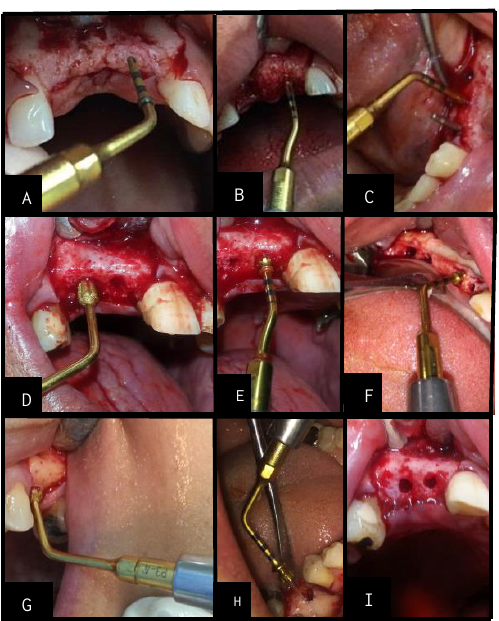
Figure 5: Complete surgical procedure of implant site preparation using piezosurgery (in sequence from A-I).